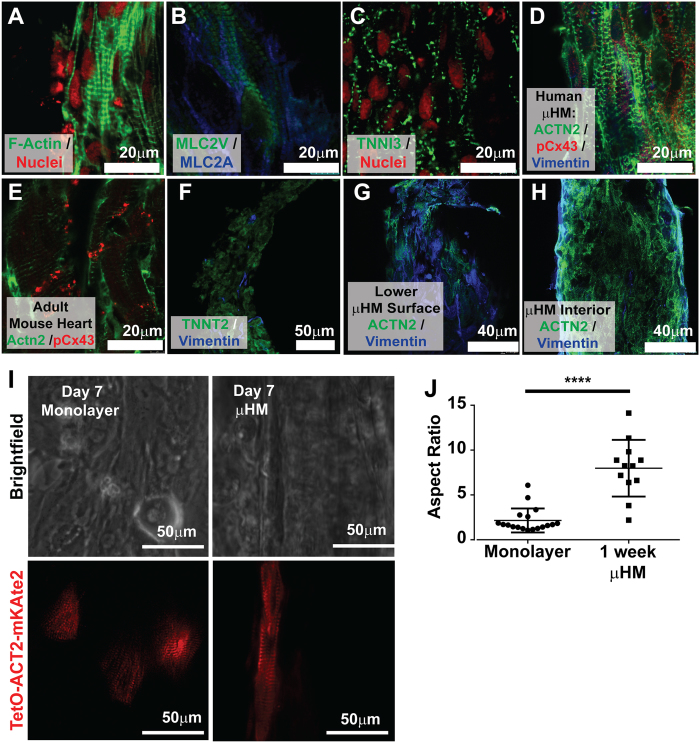
Cardiomyocyte morphology and distribution within Micro-Heart Muscle.(A–D) Representative confocal cross-sections of μHM assessed by whole-mount staining for (A) filamentous actin and nuclei (F-actin, green, and propidium iodide, red), (B) Myosin Light Chain 2v (MLC2V, green), and Myosin Light Chain 2a (MLC2A, Blue), (C) Cardiac Troponin I-C (TNNI3, green) and nuclei (propidium iodide, red), and (D) for sarcomeric α-Actinin (ACTN2, green), phospho-Connexin 43 (pCx43, red) and Vimentin (blue). (E) Representative confocal cross-section of an adult mouse ventricle stained for sarcomeric α-Actinin (Actn2, green) and pCx43 (red). (F–H) Analysis of the distribution of stromal cells (Vimentin, blue) and cardiomyocytes in the μHM (F) Cardiac Troponin T, TNNT2, green; (G–H) ACTN2, green) in (F) low magnification and (G–H) high magnification confocal cross-sections of μHM. (I) Representative images of iPS-CM harboring doxycycline induced TetO-ACTN2-mKate2 which were co-cultured with isogenic stromal cells either within monolayers (left) or μHM (right). Note cardiomyocytes form sarcomeres in both conditions, but cells appear much more elongated within μHM. (J) Quantification of the cellular aspect ratio of ACTN2-mKate2-positive iPS-CM within either μHM or confluent monolayers (**p < 10−4, 2-way t-test). Data points with the same aspect ratio value are stacked horizontally for easier viewing. Scale bars: (A–E) 10 μm; (G–H) 20 μm; (F,I) 50 μm.